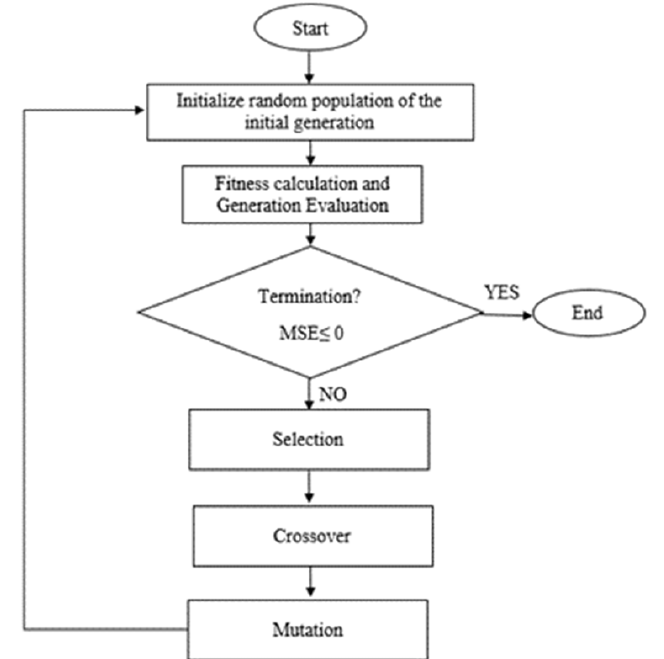
Figure 7. Flow of GA optimization.